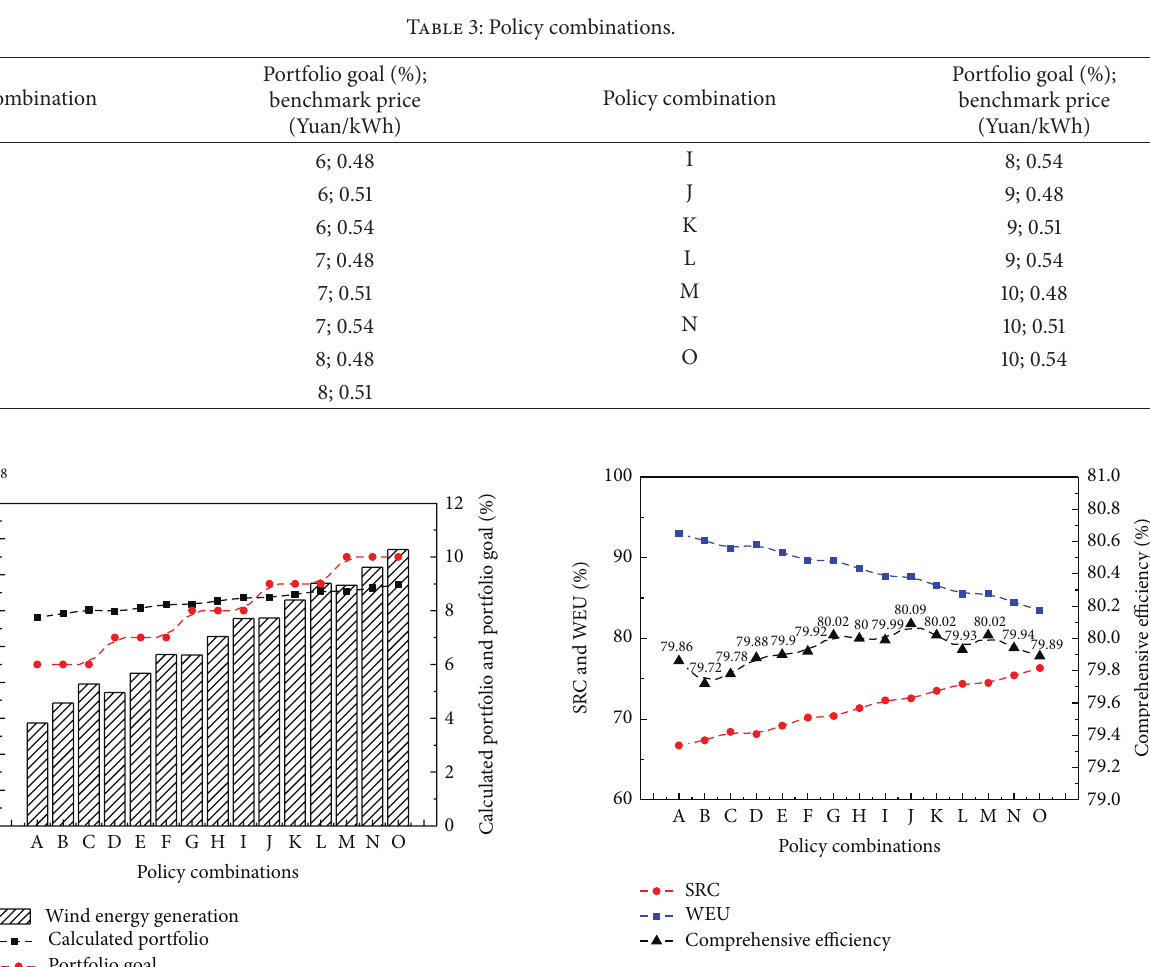
Figure 4: The comprehensive efficiency of each policy